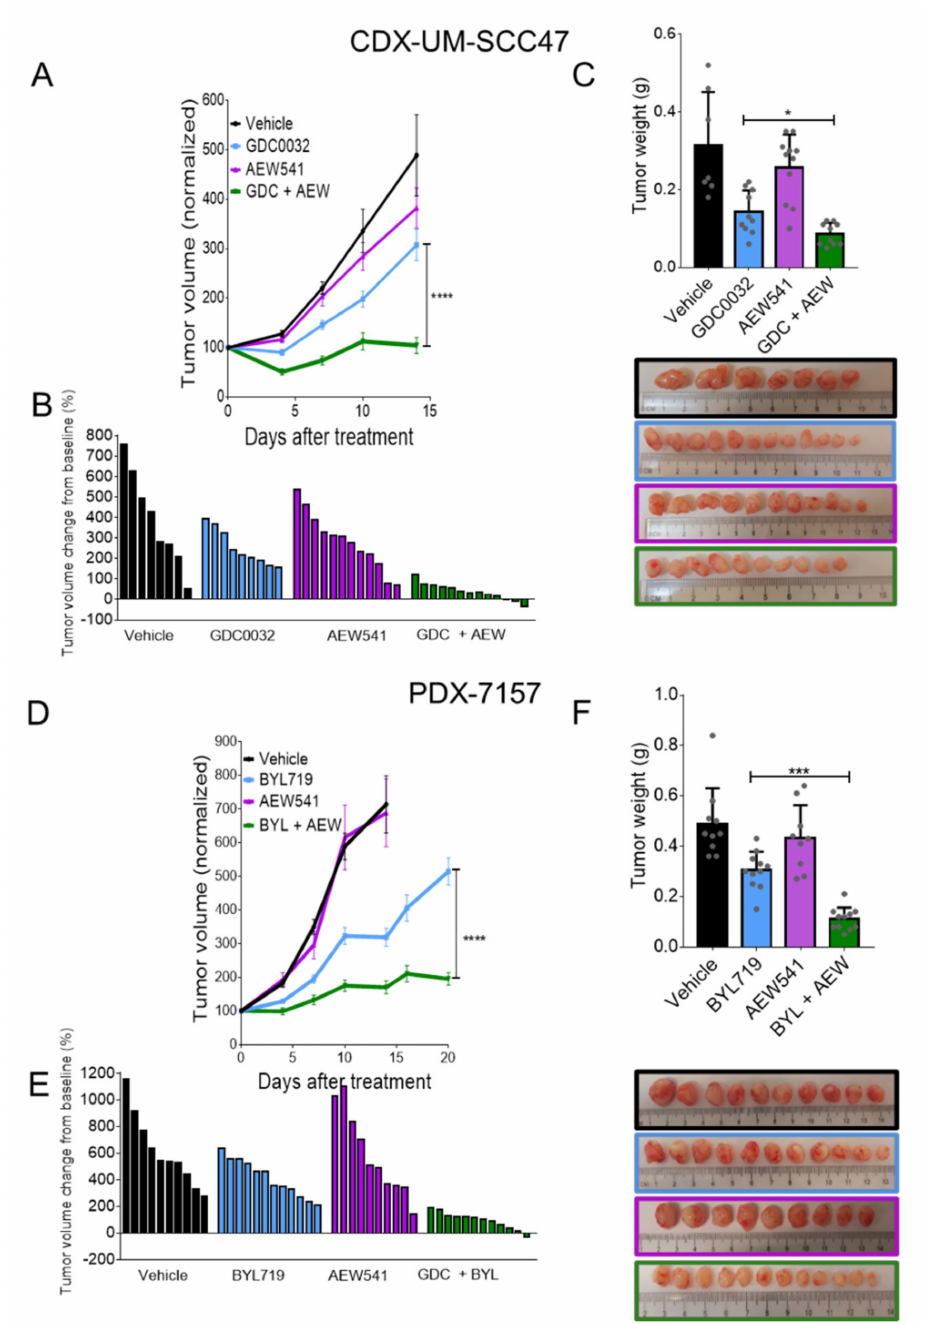
Figure 6. Dual treatment with isiPI3K and AEW541 arrested tumor growth in mice. UM-SCC47 and PDX HPV+ were injected or implanted subcutaneously (s.c.) into NSG mice. After tumors developed (tumor volume ~100 mm 3 ), mice were randomized into 4 groups (tumors n = 8–12) and treated daily with the treatment indicated below. ( A ) Growth kinetics